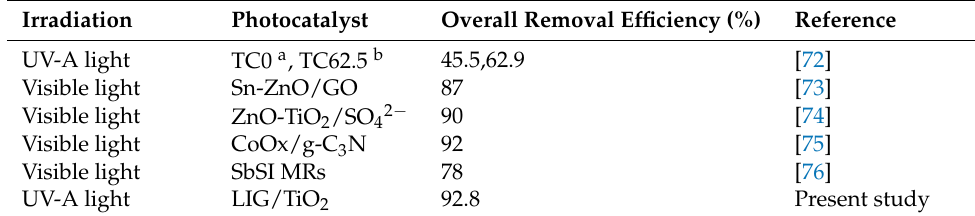
Table 4. Comparison of overall MO removal efficiency of different materials.